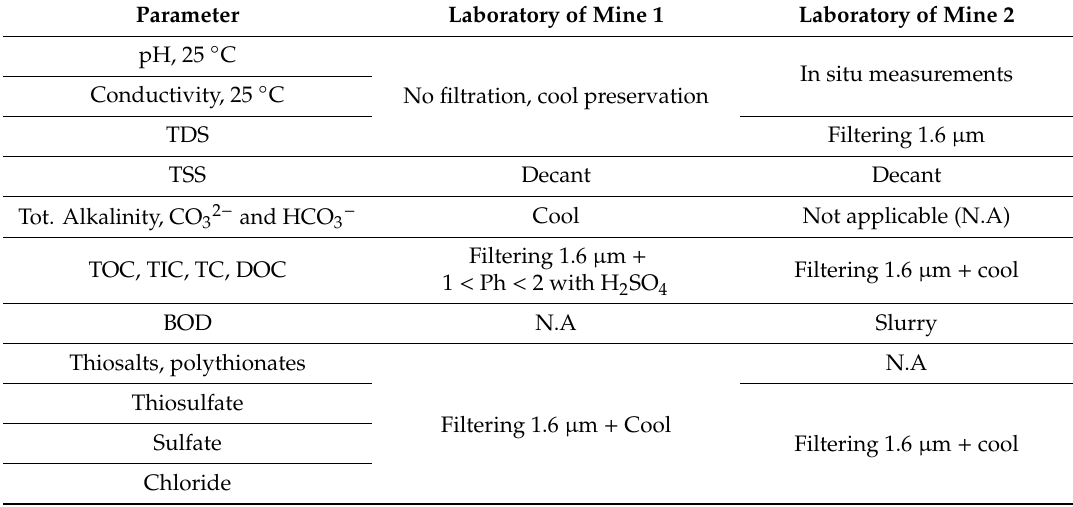
Table 2. Preservation methods for preserving di ff erent compounds / elements according to two chosen